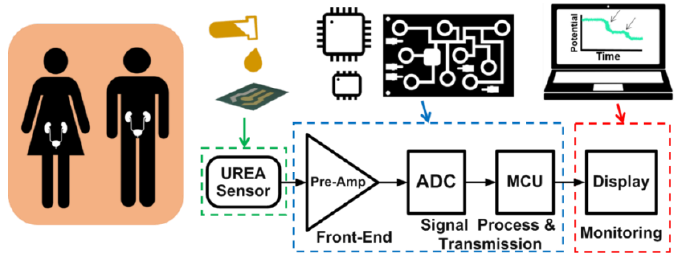
Figure 1. The proposed bioelectrochemical acquisition system prototype.